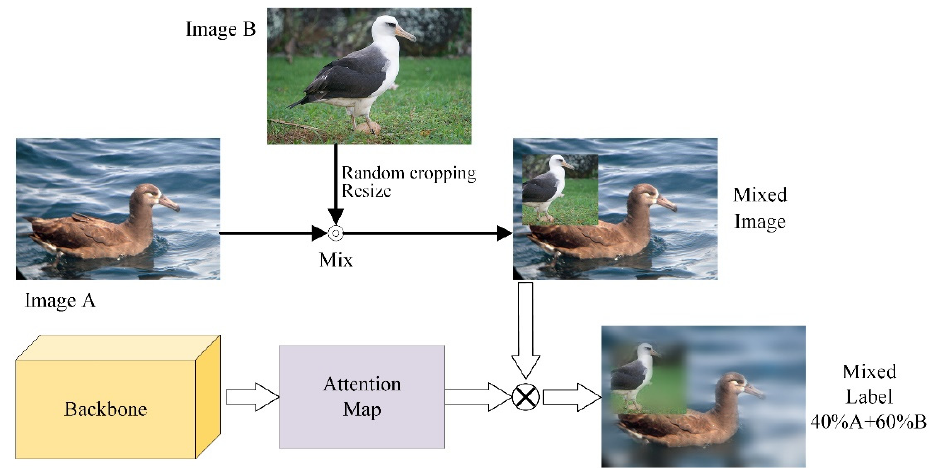
Figure 5. RAMix data augmentation.